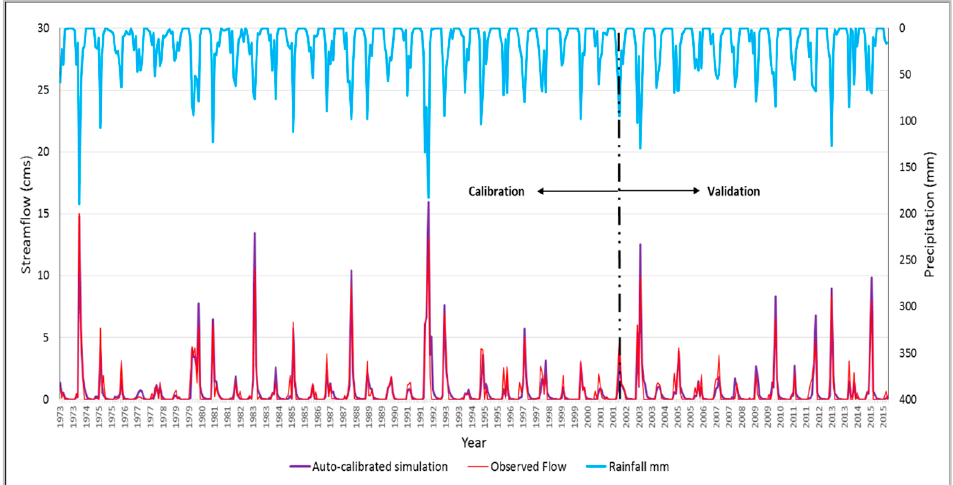
Figure 8. Comparison of measured and simulated monthly flood discharge for AZB at Jerash Bridge gauging station (AL0060) after auto ‐ calibration.